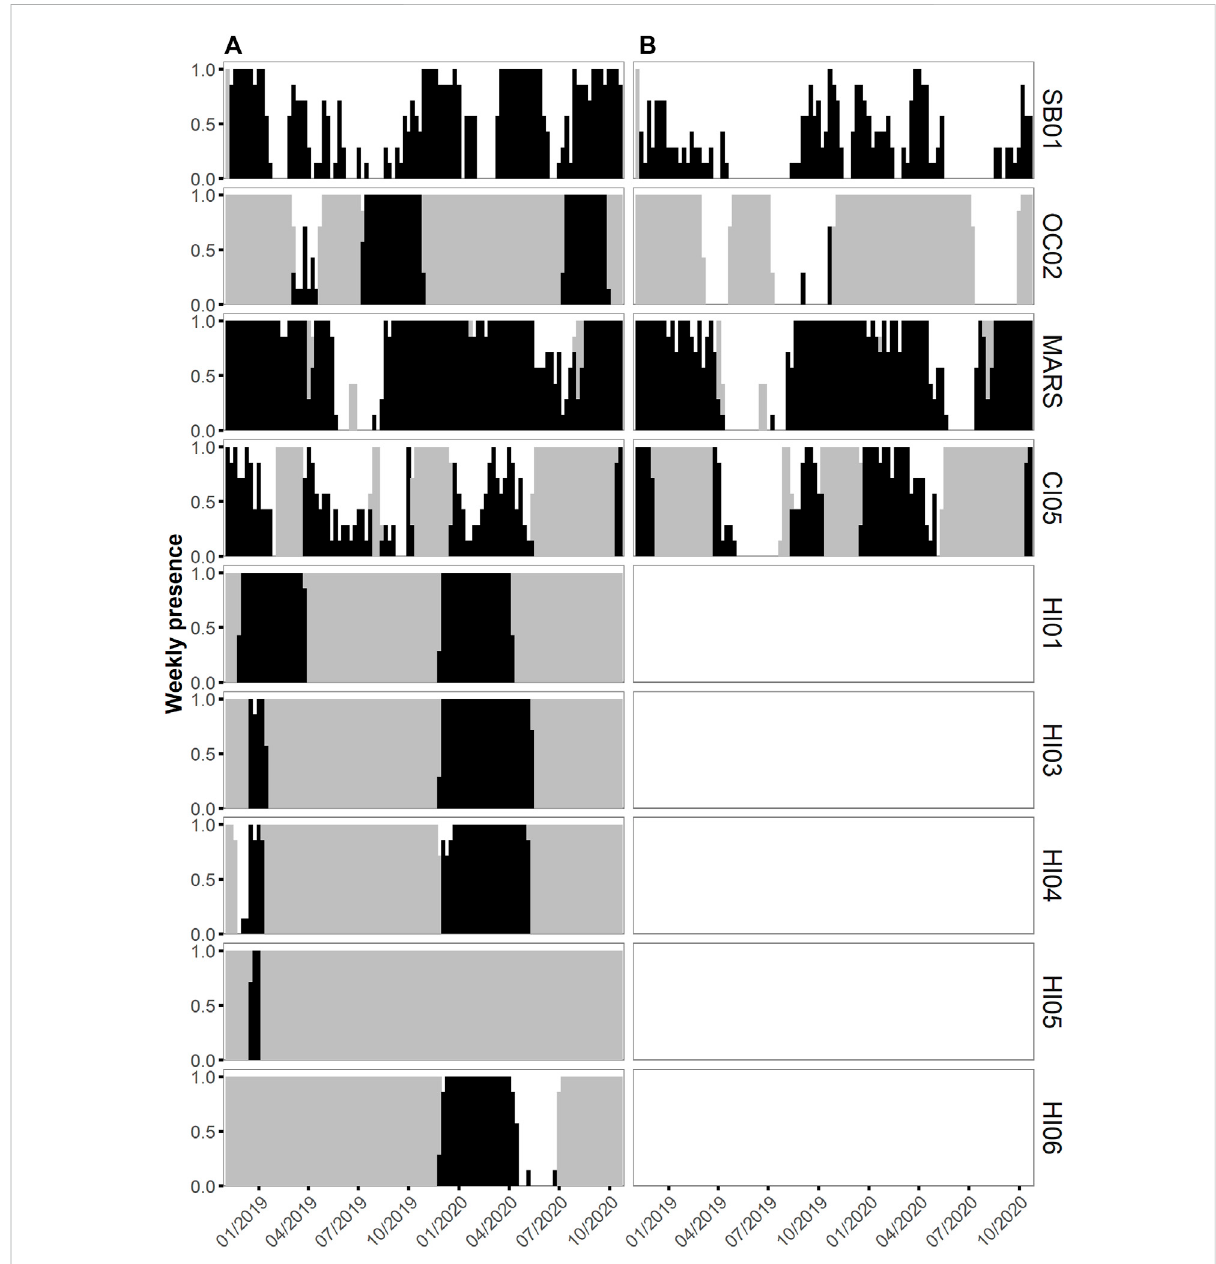
FIGURE 2 Weekly acoustic presence between 1 November 2018 to 31 October 2020 of humpback whale vocalizations (A) and fi n whale 20 Hz pulses (B) as a ratio from 0 to 1 per chosen recording site within each National Marine Sanctuary within the East Coast US region (Stellwagen Bank NMS, site SB01), the West Coast US region (Olympic Coast NMS, site OC02; Monterey Bay NMS, site MARS; Channel Islands NMS, site CI05) and the Hawai ʻ i USregion (Hawaiian IslandsHumpbackWhaleNMS,sitesHI01,HI03,HI04,HI05andHI06).Presenceisdenotedbyblackbarsanddays without data by grey bars. Fin whales were not analyzed at the Hawaiian